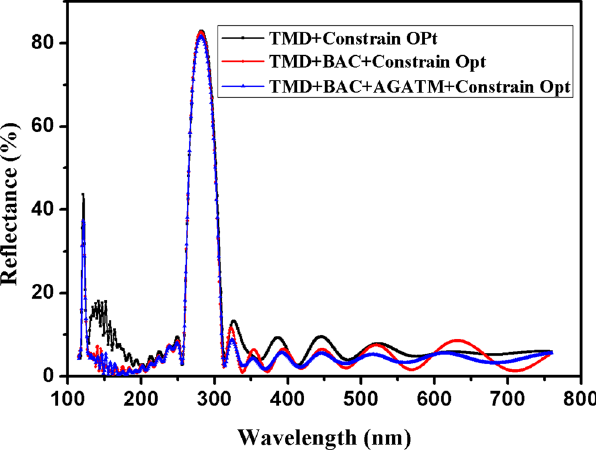
Figure 5. Theoretical reflectance curves of (TMD, TMD + BAC, and TMD + BAC + AGATMD) multilayers optimized by Constrained Optimization Function of OptiLayer software.